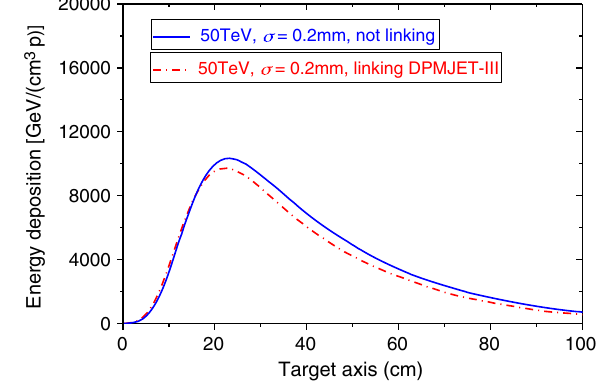
FIG. 7. Energy deposition of 50 TeV proton in copper along the target axis with and without linking FLUKA and DPMJET-III. Without linking, the maximum energy deposition is 6% higher than that for the case of linking.